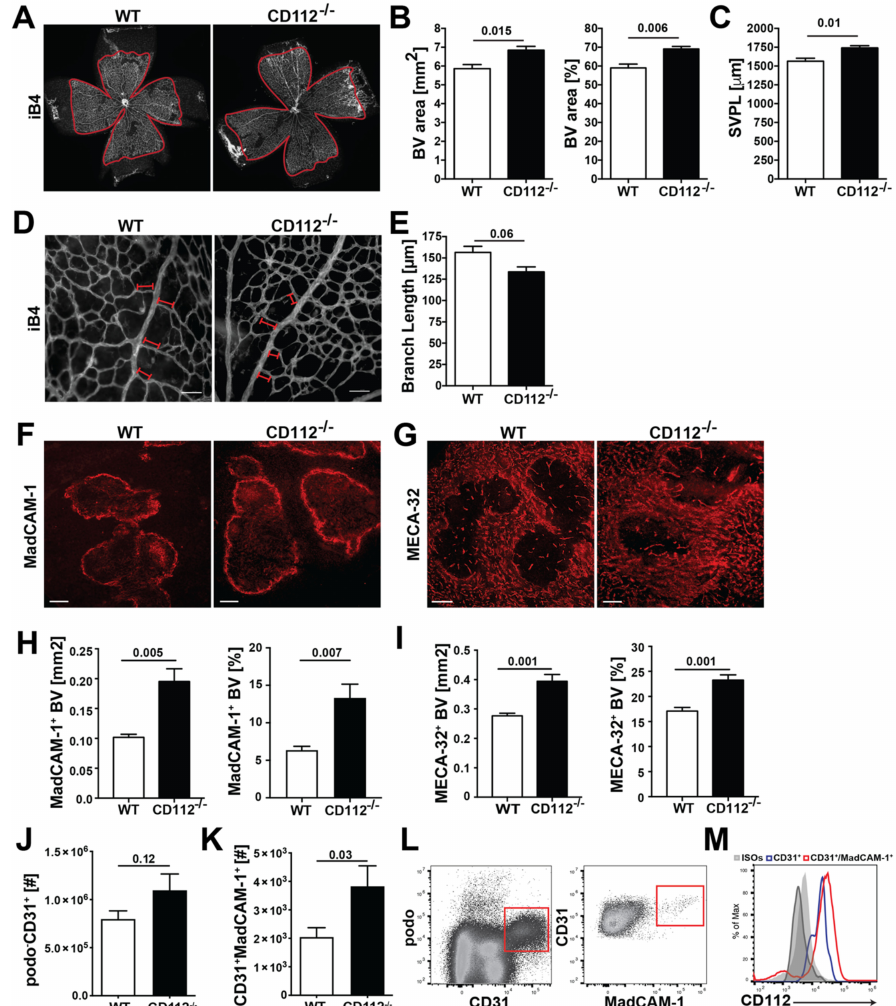
Figure 3. CD112 deficiency increases blood vessel coverage in the retina and spleen in mice. ( A – E ) Whole mounts from postnatal 6 (P6) retinas were stained with isolectin B4 (iB4) to visualize the blood vessels of the superficial vascular plexus, followed by quantification of vascular parameters. ( A ) Representative confocal images of iB4 stained P6 retinal whole mounts of CD112 − / − and Wild type (WT) pups. 4 × objective 1.0 zoom. Image-based morphometric analysis showing ( B ) the iB4+ area (left) and percent covered by blood vessels (right) and ( C ) the superficial vascular plexus length (SVPL). Scale bar: 500 µ m. Data from one out of 3 similar experiments ( n = 4–6 mice/group). ( D , E ) Upon vessel maturation, vessels undergo pruning, which can be quantified by analysing the blood vessel density. ( D ) Representative images of P6 retinas of WT and CD112 − / − stained with iB4. 20 × objective, 1.0 zoom, scale bar: 80 µ m. Analysis of ( E ) the branch length formed in the peri-arterial space in CD112 − / − mice. Data from one experiment are shown ( n = 4–6 mice/group). ( F – M ) Immunofluorescence and flow cytometry analysis of spleen single-cell suspension. ( F – I ) Sections sizes of 40 µ m of optimum cutting temperature (OCT)-frozen spleens from CD112 − / − and WT mice were stained for MadCAM-1 ( F ) and MECA-32 ( G ). Representative pictures are shown. Scale bar: 200 µ m. ( H , I ) Quantification of the MadCAM-1 + ( H ) and MECA-32 + ( I ) area in spleen of CD112 − / − mice; n = 5 mice/group. ( J , K ) Quantification of the number of ( J ) podo − CD31 + and ( K ) CD31 + MadCAM-1 + BECs present in the spleen of WT and CD112 − / − mice. Pooled data from three experiments are shown. ( L ) Gating strategy of spleen single-cell suspensions. BECs were gated on CD45 − podo − CD31 + (left), MadCAM-1 + CD31 + (right). ( M ) Representative histogram of several independent experiments showing CD112 expression by BECs in the spleen. Blue: CD31 + , red: CD31 + MadCAM-1 + , grey: isotype